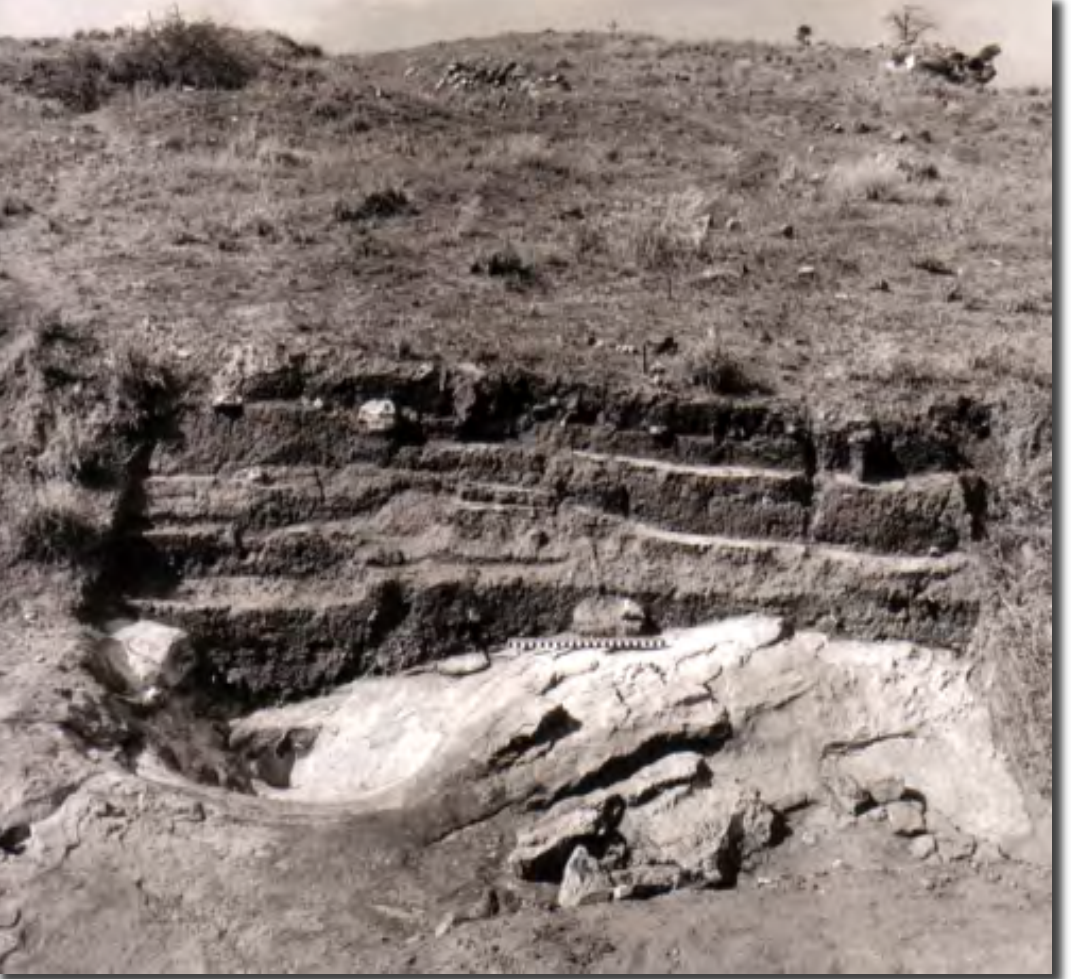
Figure 18. A vertical sequence of gravel floors visible in the wall profile of Excavation MK 3 in the deposits between the grave area and the terrace stonewall on Mapungubwe Hill, in 1973 (Meyer 1998: